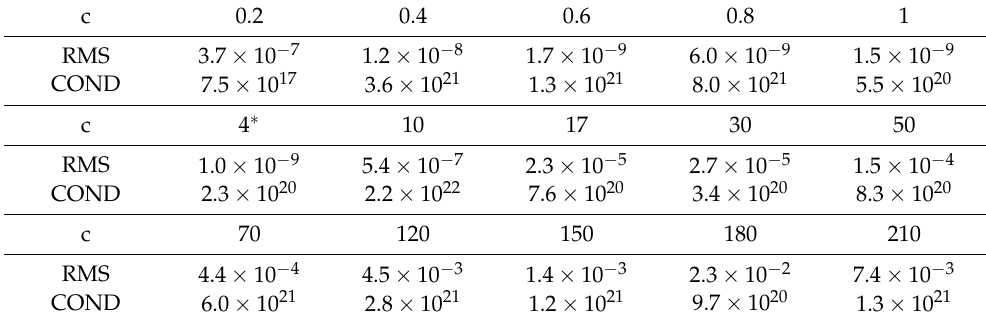
Table 6. N d = 800, N t =